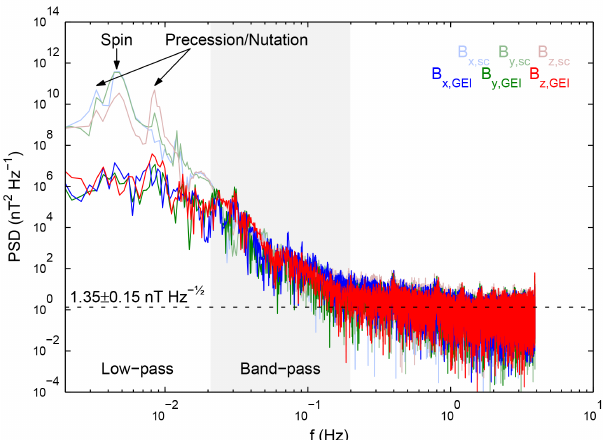
Figure 6. Power spectral densities (PSDs) of the components of the calibrated science mode data (19 November 2013) in both the orthogonal spacecraft fixed frame (lighter) and despun GEI frame, where IGRF has been subtracted from the latter. x, y and z compo- nents are given by blue, green and red respectively. The noise level at 1Hz in the despun data is indicated by the black dotted line.